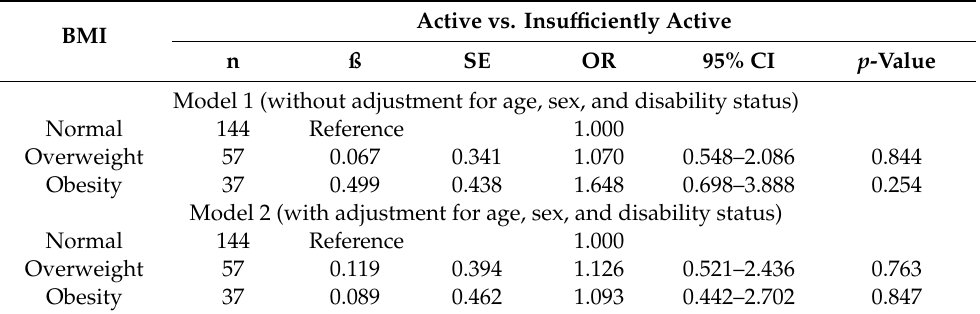
Table 2. Physical activity in relation to World Health Organization’s standard of obesity assessed by multivariable logistic regression analysis.